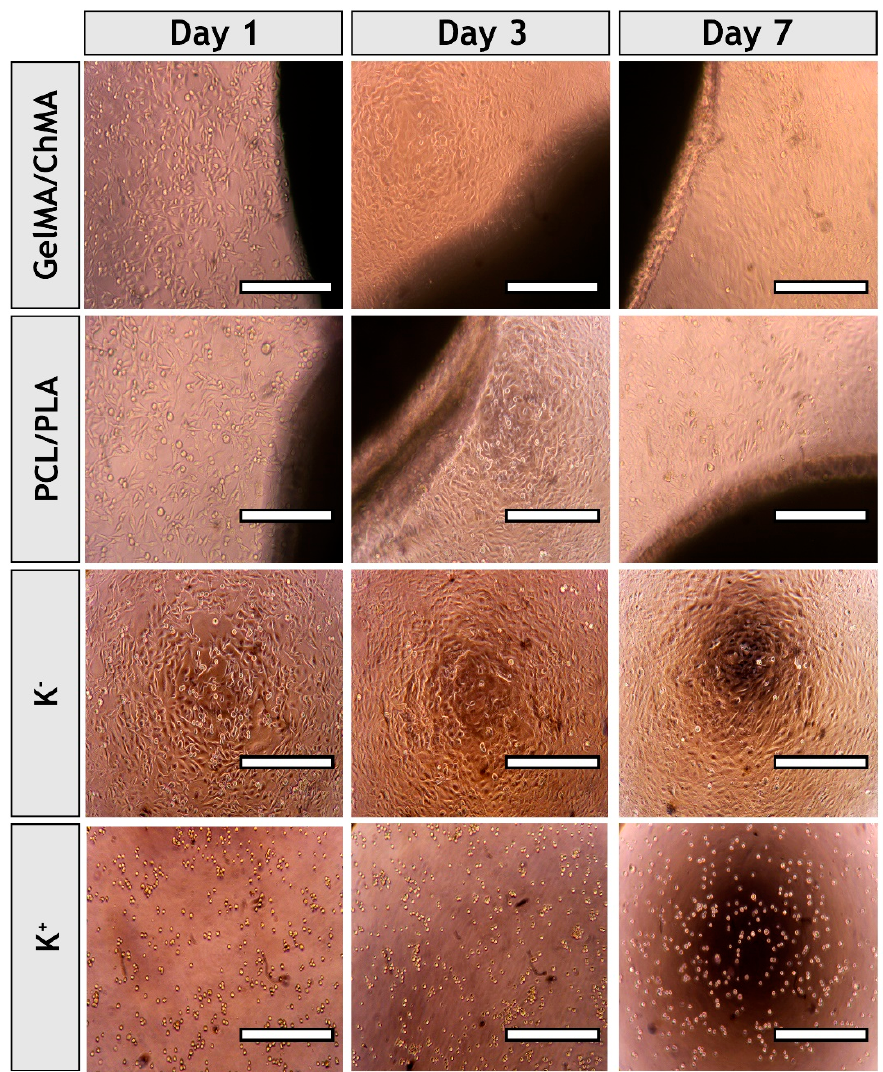
Figure 8. Optical microscopic photographs of NHDF cells in the presence of the each of the produced fibrous meshes after one, three and seven days of incubation. K − , negative control; K + , positive control. Original magnification, 100×.